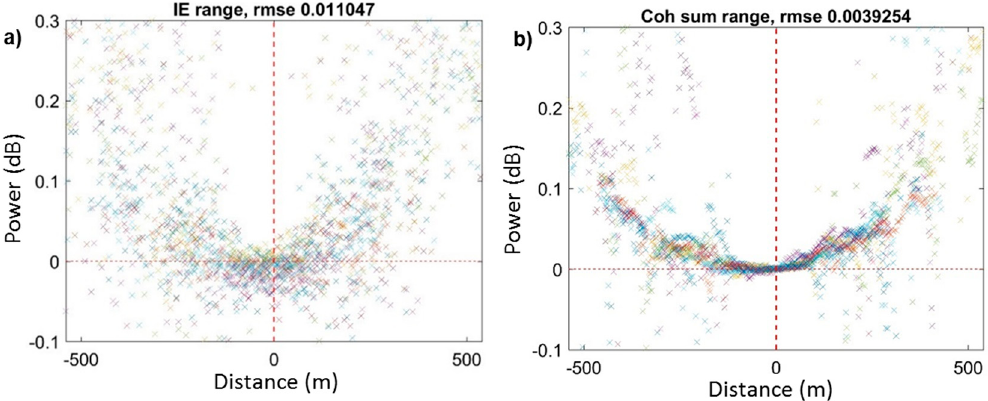
Figure 13. ( a ) Range estimates with raw IEs; ( b ) Range estimates with coherently integrated bursts of IEs.